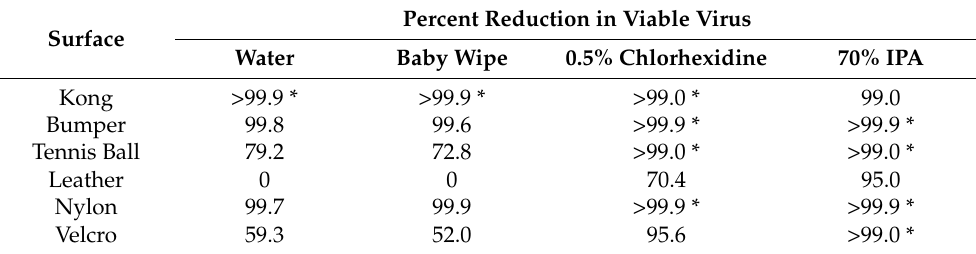
Table 1. Effect of wiping with neutralization solutions on dried virus droplets deposited on test surfaces. N = 3; * titer fell below limit of detection of the assay, meaning absolute reduction in virus yield could be greater than listed.